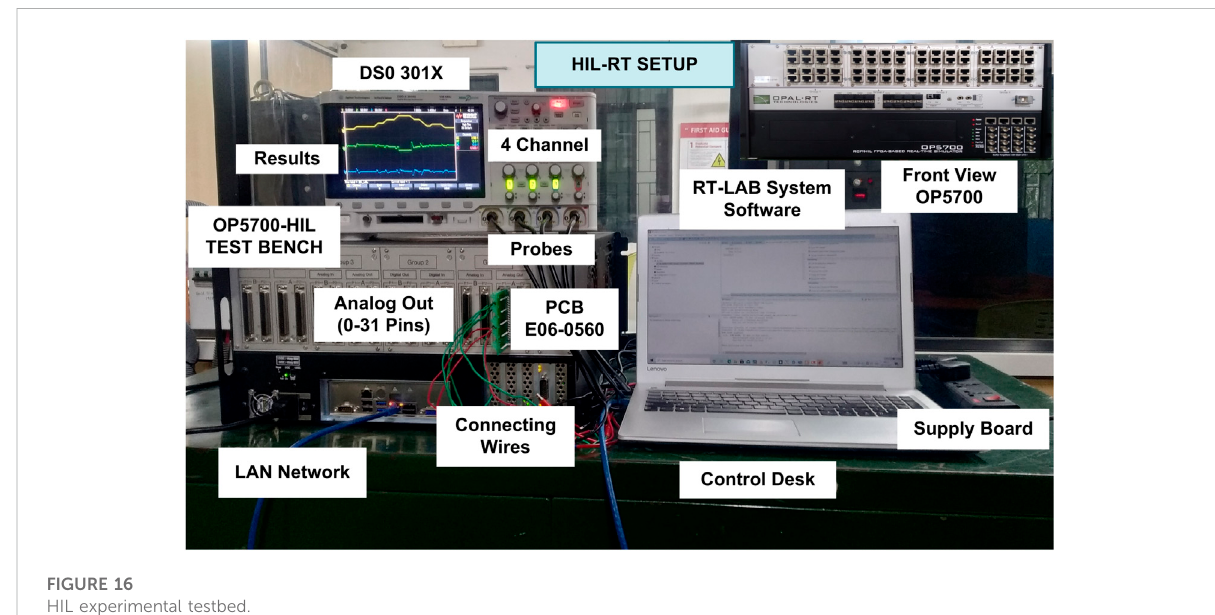
FIGURE 16 HIL experimental testbed.